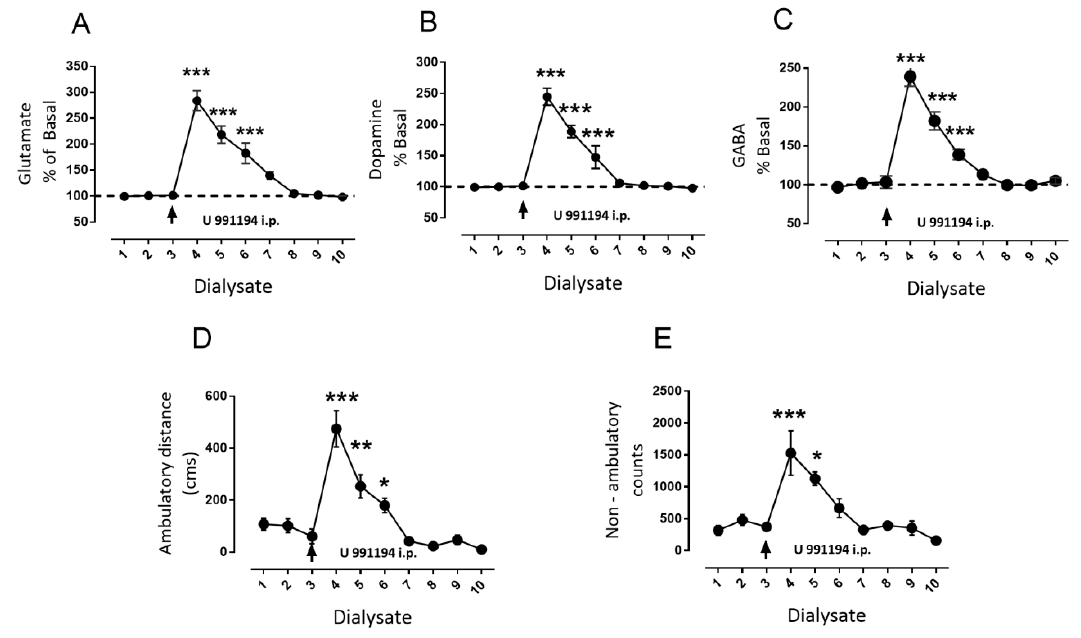
Figure 6. Systemic blockade of D3R with U 99194A also increased intra-nigral glutamate, GABA, dopamine, and locomotor activity. ( A ) reveals the percentage of change of interstitial nigral glutamate in dialysate X with respect to dialysate 1 (baseline), and the arrow indicates the injection of a single dose of D3R selective antagonist U 99194A (25 mg / kg i.p.). ( B , C ) are the same as ( A ), but with dopamine and GABA, respectively. In ( D , E ), change in ambulatory distance is in cm, and non-ambulatory activity is in light-beam counts in the 20 min period during which the respective dialysate was collected. * p < 0.05, ** p < 0.001, and *** p < 0.001 with respect to dialysate three (before antagonist injection), two-way ANOVA followed by Tukey, n = 6 rats.